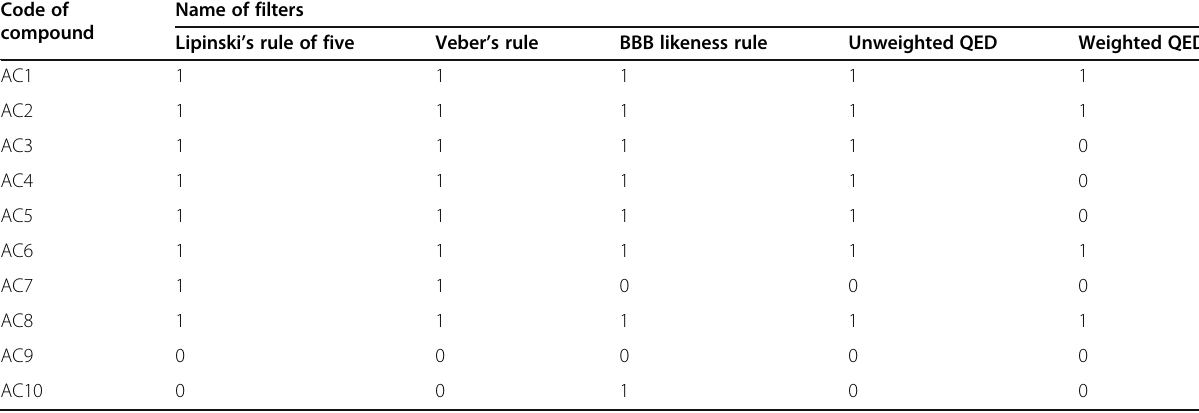
Table 6 Drug-likeness property of compounds of fermented Allium cepa peels methanolic extract Code of